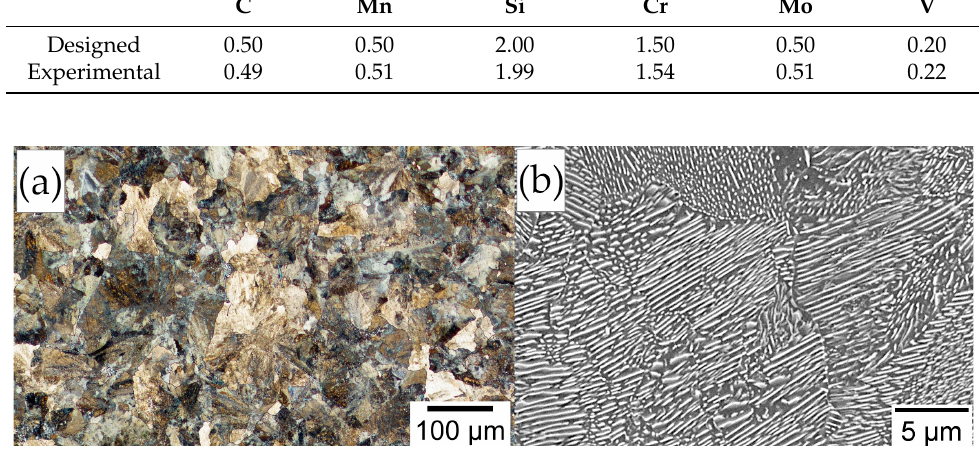
Figure 5. Microstructure of manufactured steel after homogenization and hot forging process. Fully fi ne-dispersed pearlitic structure. ( a ) Light optical microscopy. ( b ) Scanning electron microscopy.